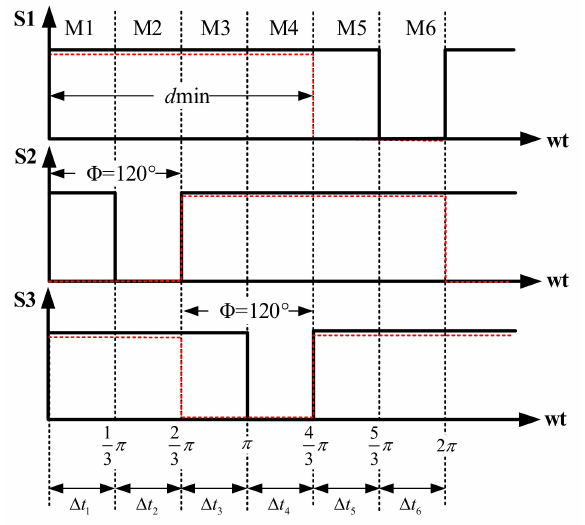
Figure 2. Control signals and operating modes in the three-input step-up converter.